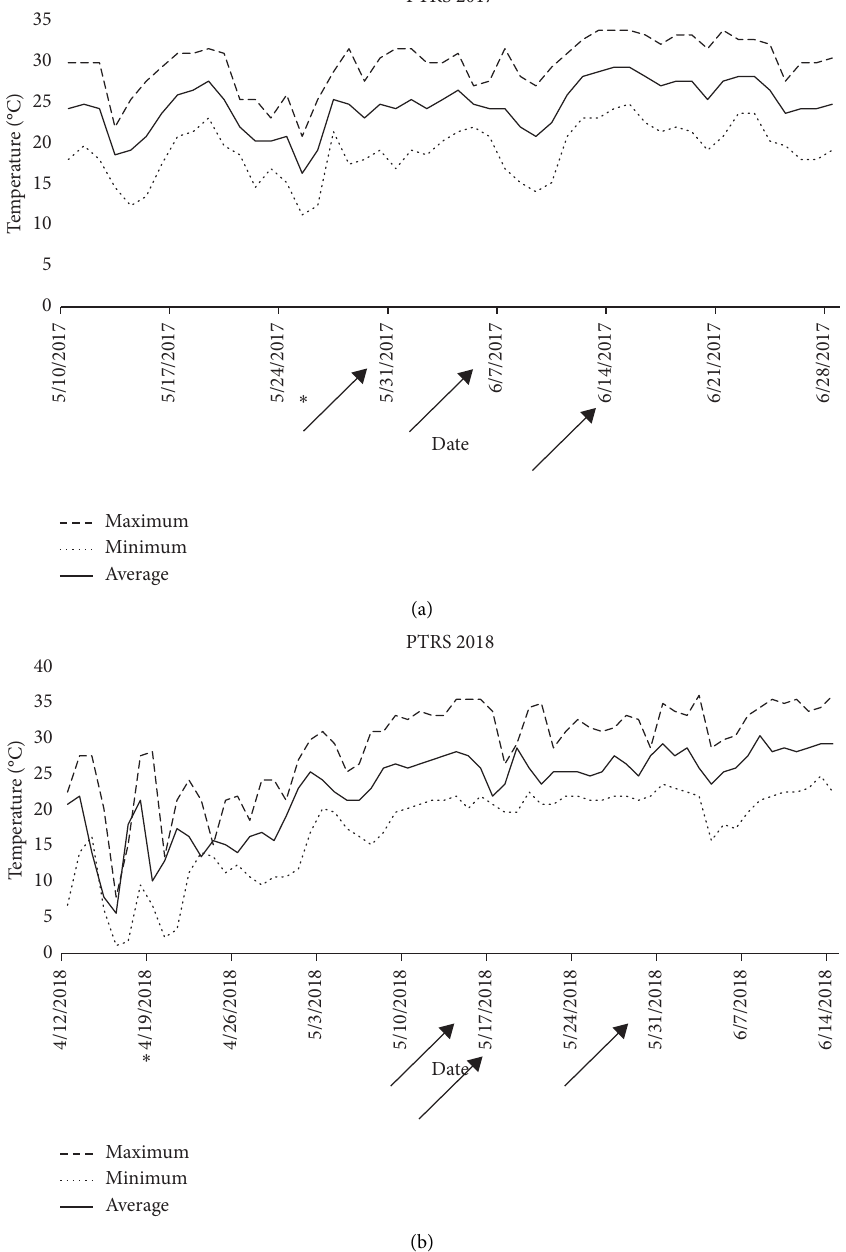
Figure 1: Daily minimum, maximum, and average temperatures at the Pine Tree Research Station near Colt, AR, in (a) 2017 and (b) 2018 (a, b) for dates ranging from 7 days before planting to 14 days after the last application for the florpyrauxifen-benzyl and imazethapyr experiment. Rice cultivars CL111, CL272, and CLXL745 were planted on April 19, 2018, and on May 27, 2017. The 1-leaf (lf) applications were made on May 30 and 14, 3-lf applications were made on June 6 and May 17, and 5-lf applications were made on June 14 and May 30 in 2017 and 2018, respectively. Planting date is indicated by ( ∗ ) and application dates are indicted by an